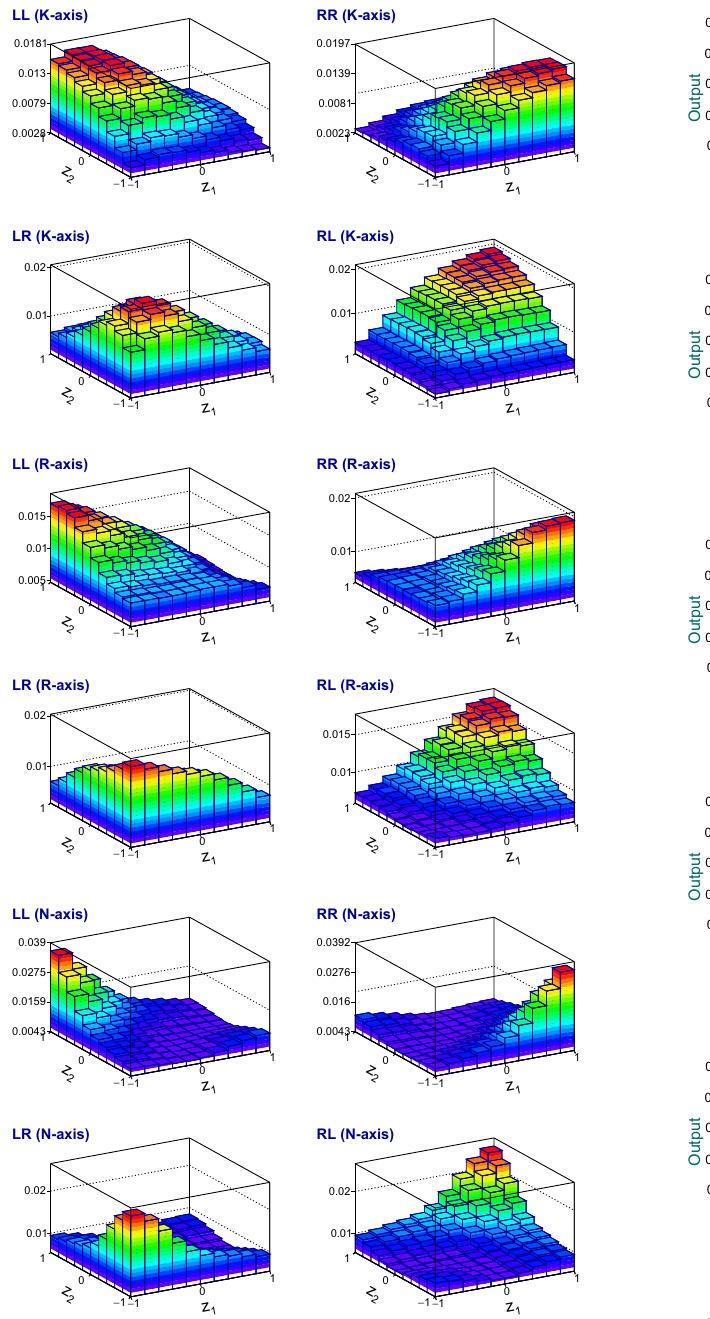
Fig. 2 Reconstructed normalised templates for the three sets of axes and for the LL , RR , LR and RL polarisations